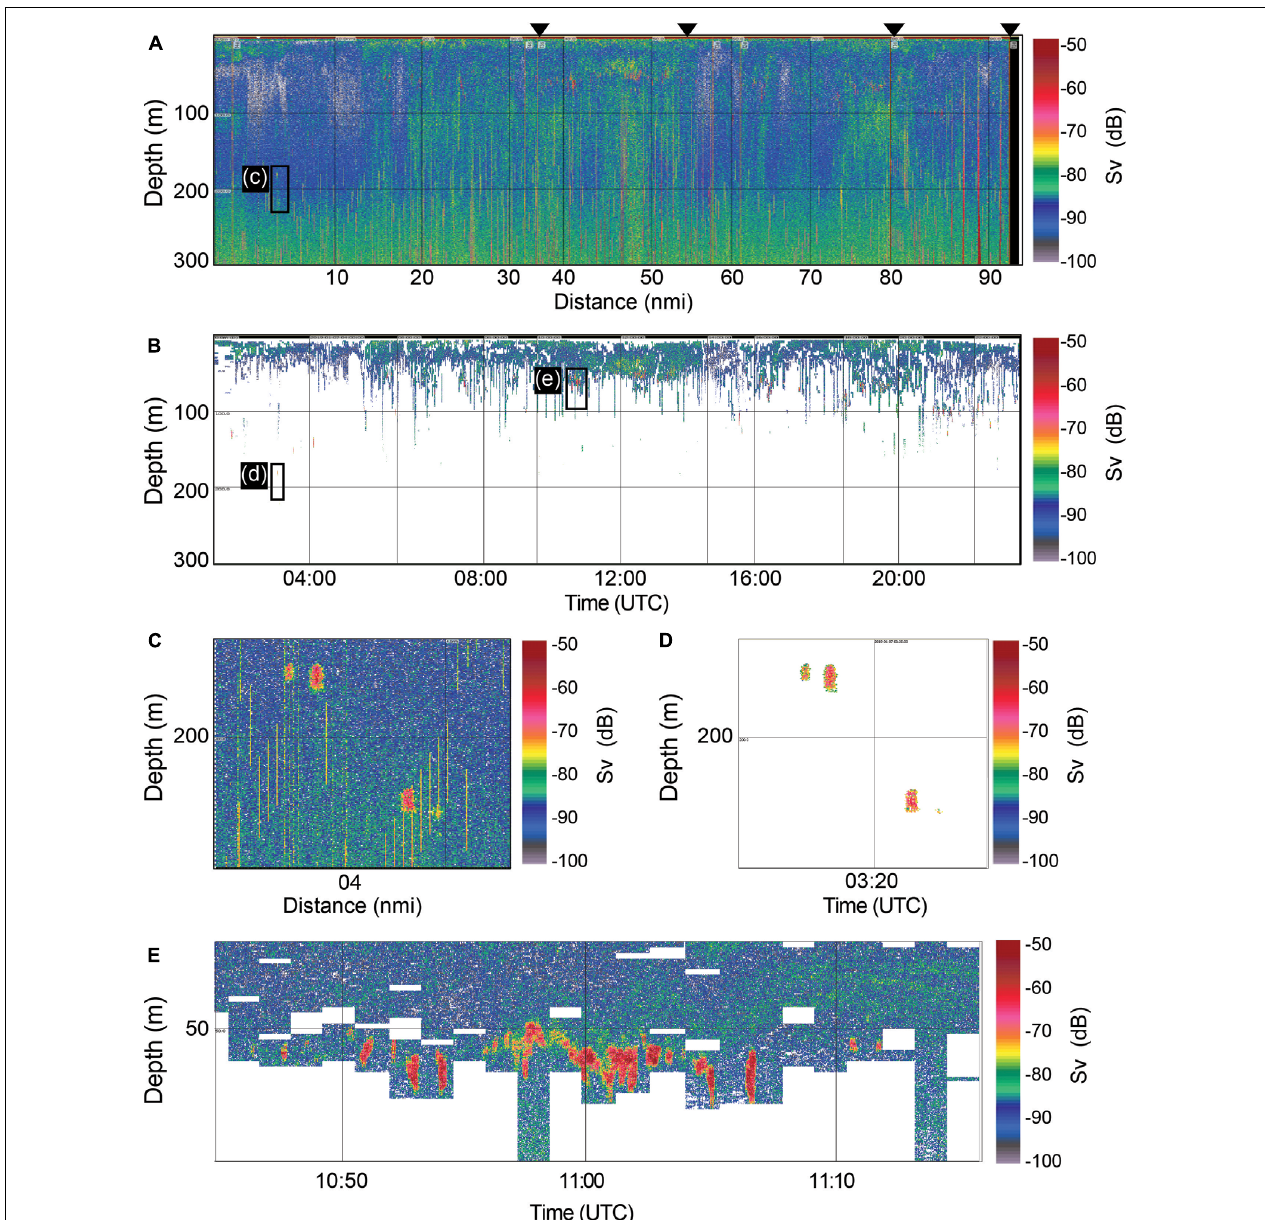
FIGURE 2 | Example echograms. The original Sv echogram at 120 kHz on 7 January 2019 (A) , the corresponding noise cleaned echogram (B) , the expanded echogram from the black box in the Sv echogram around 200 m (C) , the expanded echogram from the box in black in the noise cleaned echogram around 200 m (D) , the expanded echogram from the black box in the noise cleaned echogram around 50 m (E) . Black triangles indicate the cruise track line, which means that there were four cruise track lines on that day.